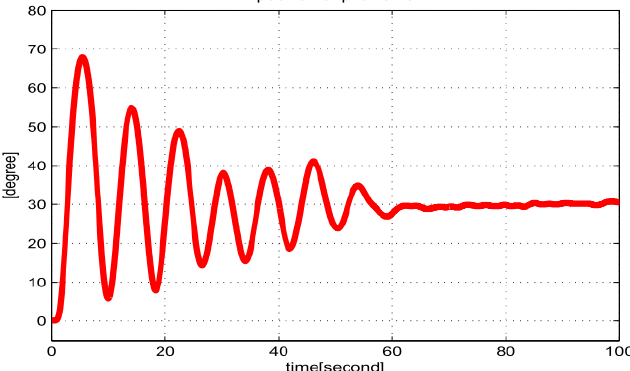
Fig. 3. Angular pitch position when lag compensator of the form was applied on the main motor.